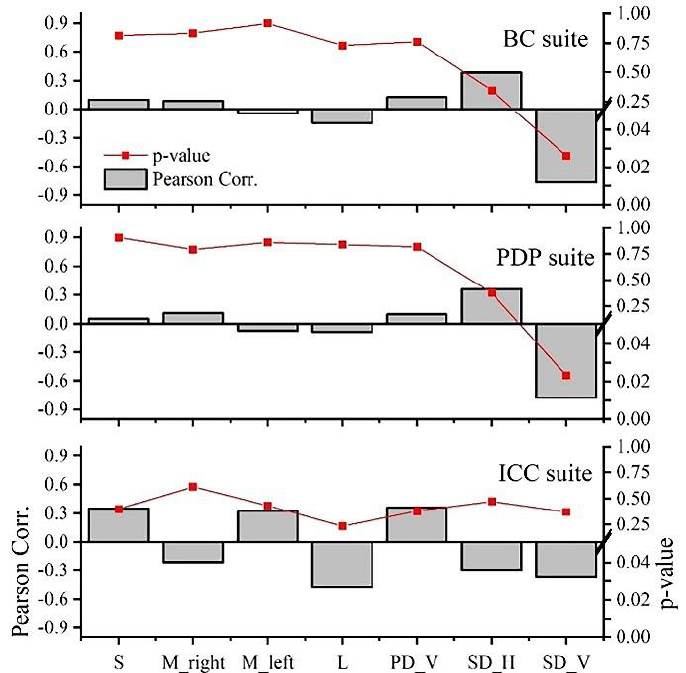
Figure 14. Pearson correlation coefficients between glacier surface features and classification accuracy for the three data sets and p -value. The x -axis represents the four aspect-beam angle ranges and the three secondary statistical features (see Section 3.7). The left y -axis represents the Pearson correlation coefficient between each glacier surface feature and glacier classification accuracy, and the right y -axis represents the p -value corresponding to the Pearson correlation coefficient. The three histograms from top to bottom correspond to BC, PDP, and ICC suites.